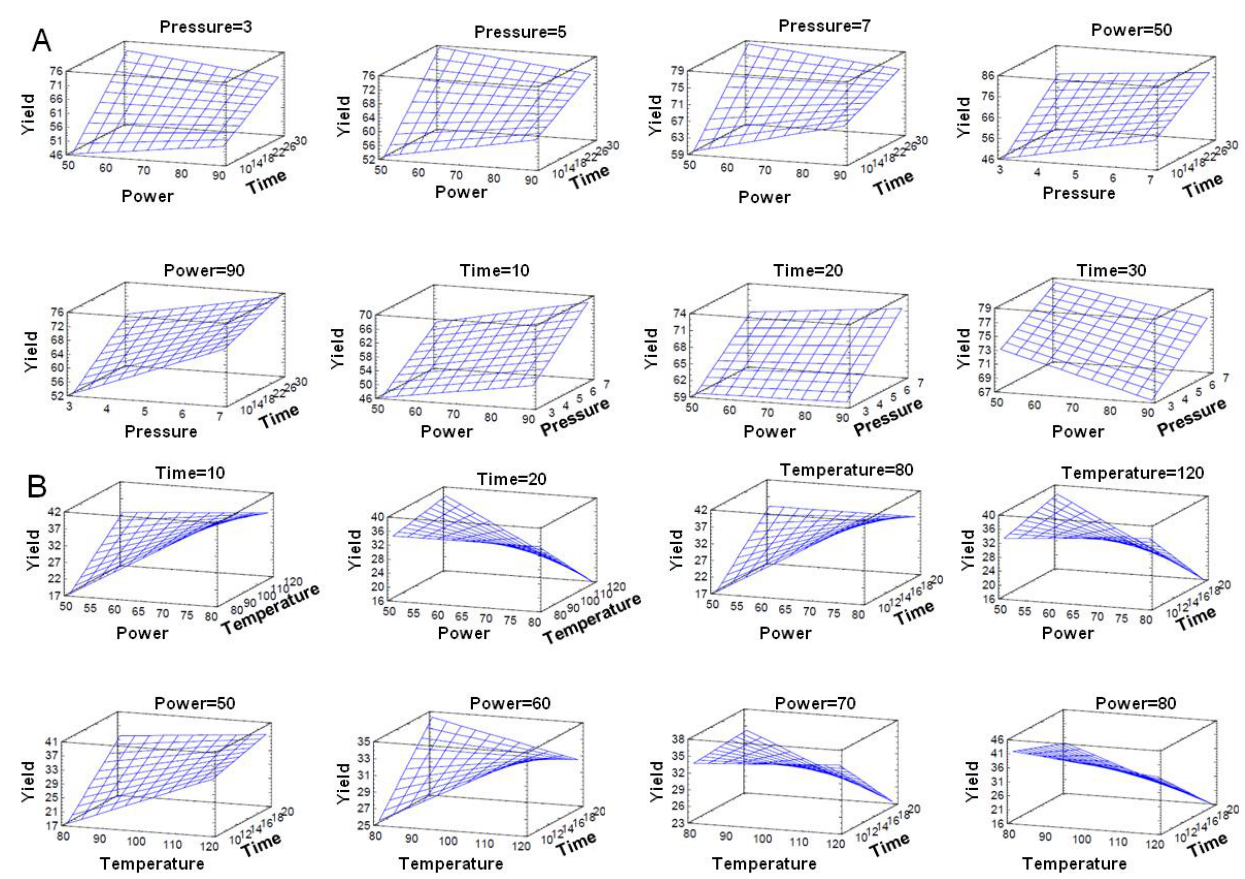
Figure 2. Response-surface graphs representing: the effect of power, pressure and time on the AS101 yield by Method A ( A ) and relative effect of time; temperature and power on the AS101 yield by Method B ( B